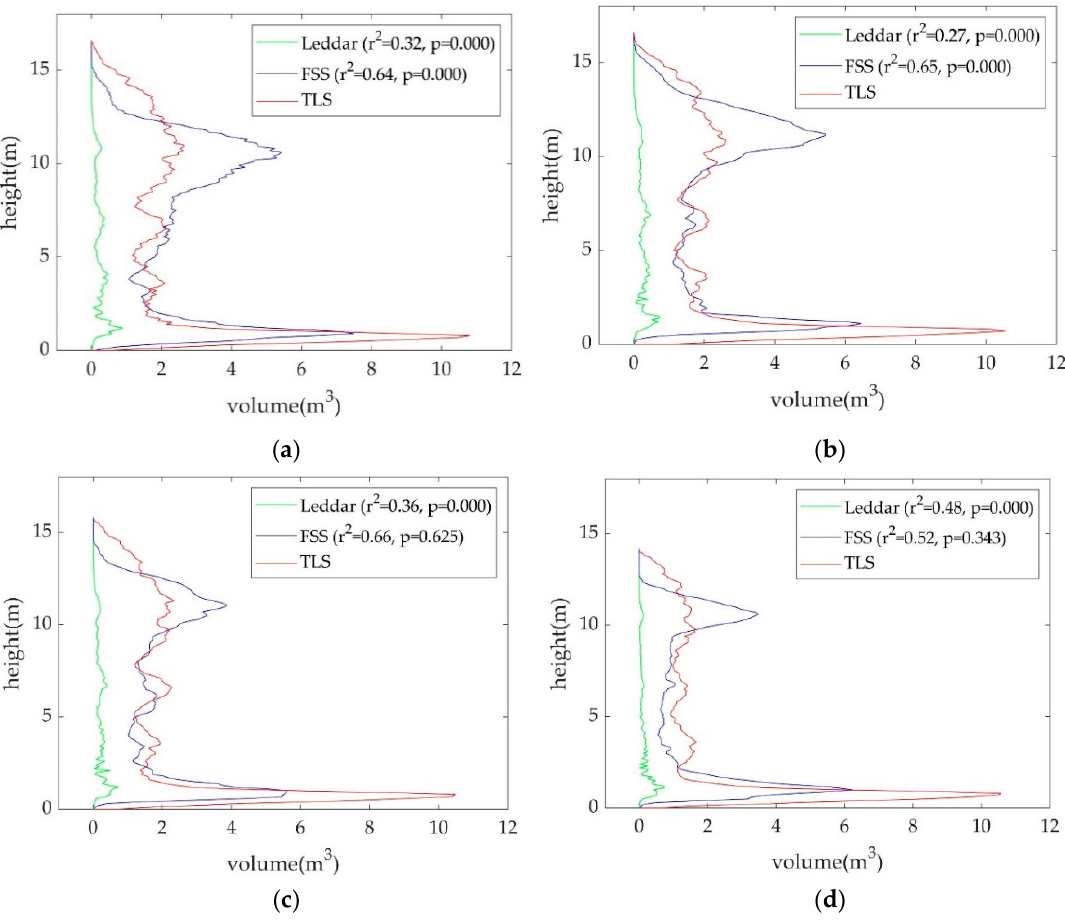
Figure 10. Vertical volume profiles from TLS, fusion-based, and Leddar-only point clouds on ( a ) September 9th, ( b ) September 17th, ( c ) October 1st, and ( d ) October 17th, 2018, where the horizontal axis denotes volume of voxels with a unit voxel of 0.1 m 3 , and the vertical axis denotes height in meters.